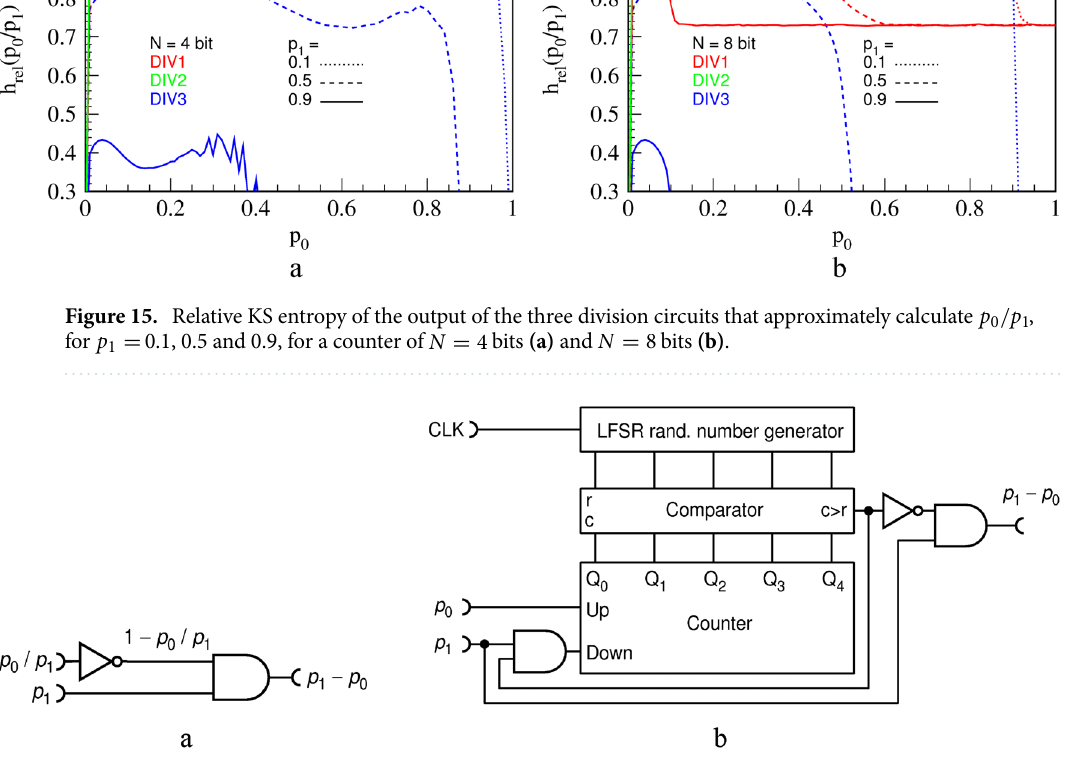
Figure 16. Subtraction via division principle (a) ; a subtraction circuit SUB1 that uses DIV1 (b)